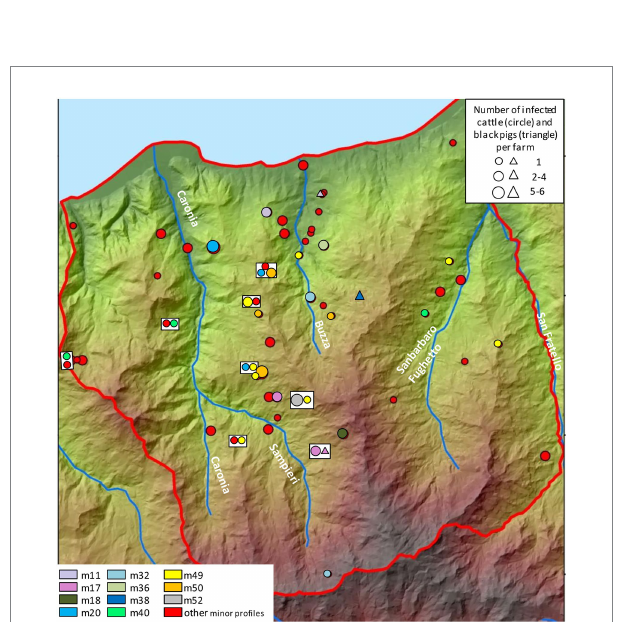
FIGURE 8 Distribution and frequency of the minor genetic profiles of Mycobacterium bovis . Cattle and black pigs are marked as circles and triangles, respectively. The size of the circle and triangle symbols is proportional to the number of infected animals per herd. Symbols inside rectangles refer to the same herd. The Caronia, Sampieri, Buzza and Sanbarbaro Fughetto streams are indicated. The map was adapted from QGis.